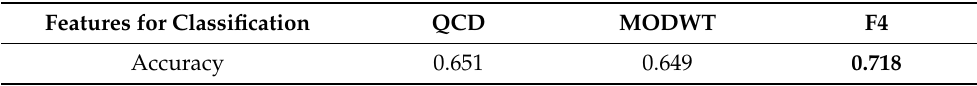
Table 1. Average accuracy of F4 and the individual